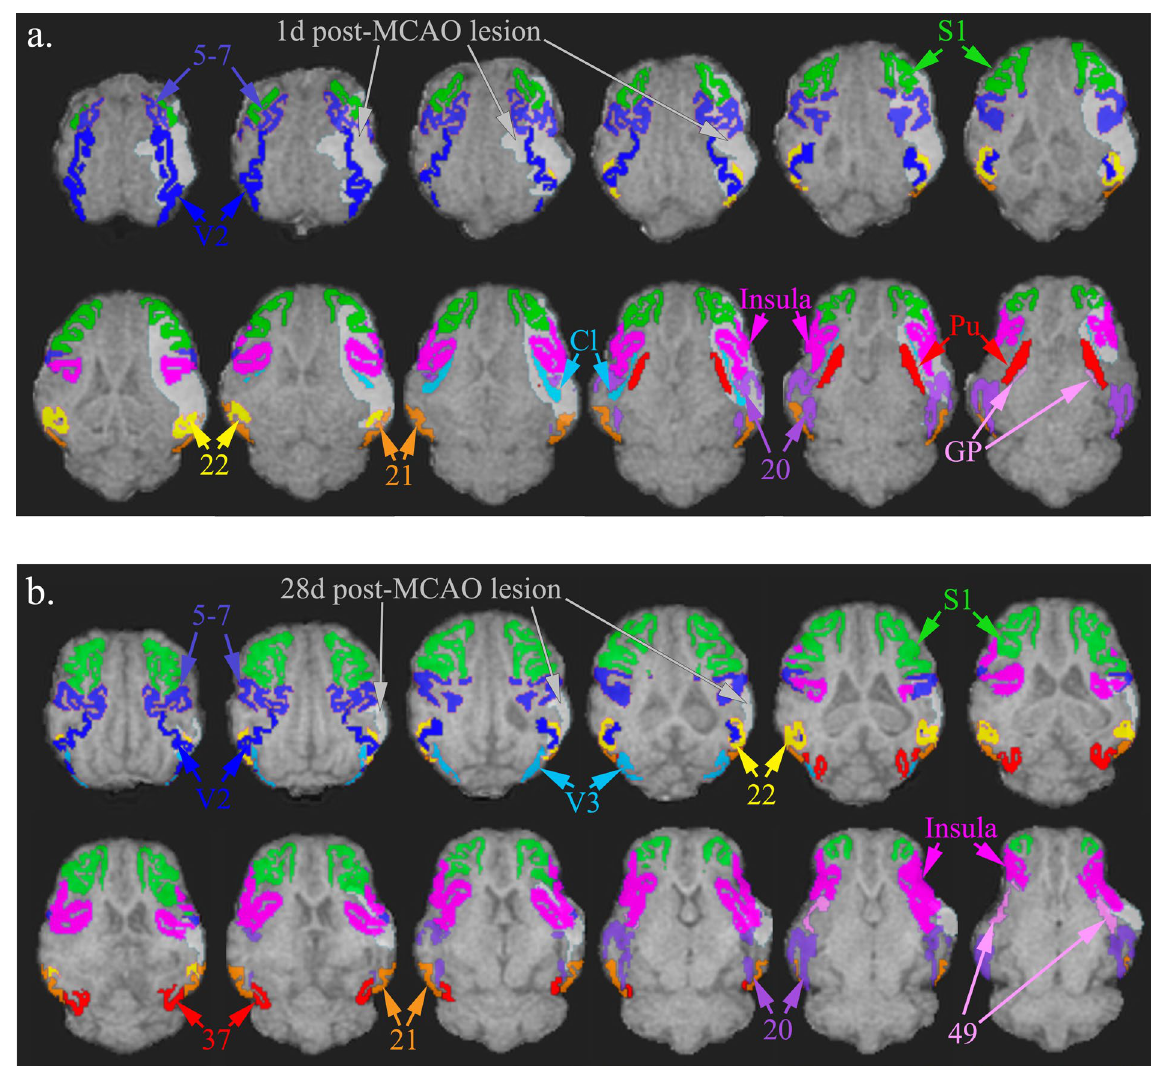
Figure 2. Structures most highly lesioned by MCAO in a porcine ischemic stroke model. Images depict axial T1 brain overlay with entire bilateral structures most affected by the lesion. The structures with the highest percentage of infarction (percent of structure, PoS) at 1d post-MCAO in descending order include the claustrum ( Cl ), inferior temporal gyrus ( Brodmann’s Area 20 ), superior temporal gyrus ( Brodmann’s Area 22 ), insular cortex ( Insula ), middle temporal gyrus ( Brodmann’s Area 21 ), putamen ( Pu ), somatosensory association cortex ( Brodmann’s Area 5–7 ), secondary visual cortex ( V2 ), globus pallidus ( GP ), and primary somatosensory cortex ( S1 ) ( a ). At 28d post-MCAO, the structures with the highest level of lesioning included the middle temporal gyrus ( Brodmann’s Area 21 ), superior temporal gyrus ( Brodmann’s Area 22 ), inferior temporal gyrus ( Brodmann’s Area 20 ), somatosensory association cortex ( Brodmann’s Area 5–7 ), insular cortex ( Insula ), associative visual cortex ( V3 ), primary somatosensory cortex ( S1 ), prepiriform area ( Brodmann’s Area 49 ), fusiform gyrus ( Brodmann’s Area 37 ), and secondary visual cortex ( V2 ) ( b stride length (Fig. 3b; Pre: 89.01 ± 3.42 cm vs. Day 2: 57.98 ± 10.96 cm, p = 0.0042), step length (Fig. 3b; Pre: 44.36 ± 2.05 cm vs. Day 2: 29.65 ± 5.00 cm, p = 0.0031), and swing percent (Fig. 3c; Pre: 51.93 ± 2.47% vs. Day 2: 31.45 ± 6.14%, p = 0.0034), along with an increase in stance percent (Fig. 3c; Pre: 48.06 ± 2.49% vs. Day 2: 68.55 ± 6.12%, p = 0.0034) relative to pre-MCAO. Velocity (Fig. 3a; Day 8: 114.77 ± 48.21 cm/s, p = 0.0168), cadence (Fig. 3a; Day 8: 90.03 ± 27.37 stride/min, p = 0.0247), stride length (Fig. 3b; Day 8: 73.29 ± 10.29 cm, p = 0.0289), step length (Fig. 3b; Day 8: 36.96 ± 5.39 cm, p = 0.0324), swing percent (Fig. 3c; Day 8: 38.98 ± 5.53%, p = 0.0104), and stance percent (Fig. 3c; Day 8: 61.03 ± 5.52%, p = 0.0104) continued to display deficits at 8d post- MCAO. No significant ( p > 0.05) differences between the MCAO and non-stroked groups were measured pre- MCAO. Non-stroked pigs did not have any significant differences at any measured timepoints (Fig. 3). Stroked animals exhibited signs of recovery after 8d post-MCAO, showing no significant changes in measured param- eters to non-stroked animals or pre-stroke values ( p > 0.05). Gait parameters for the other three limbs, right front (RF), left hind (LH), and right hind (RH), are detailed in Supplementary Fig. 4.